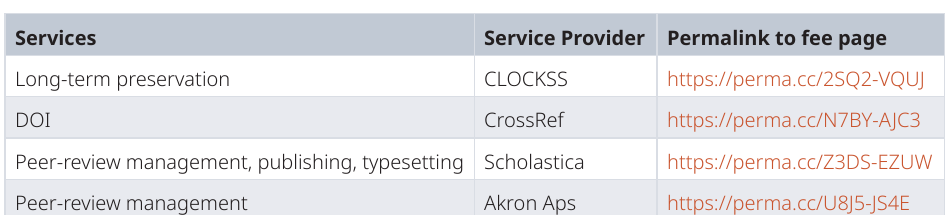
Table 1. Publishing services and their fees.